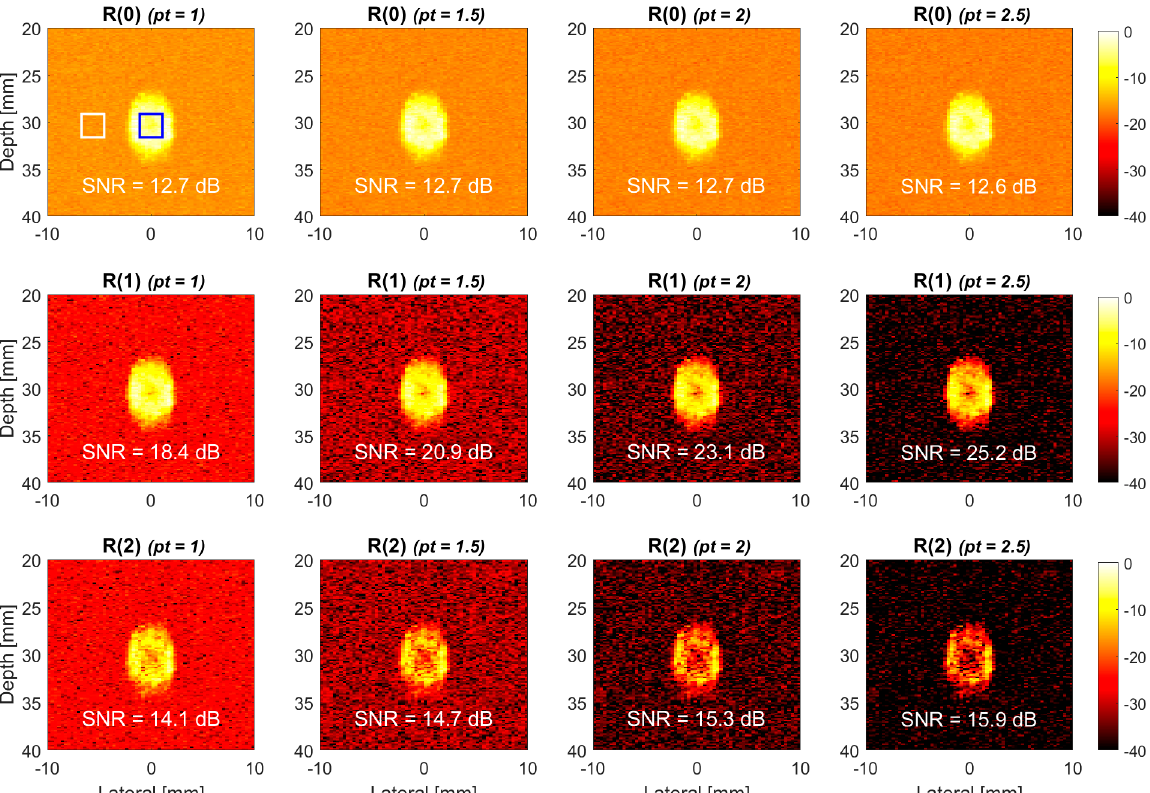
Figure 4. Simulated TMAS power Doppler images of cross-view flow phantom for R(0), R(1) and R(2) images with the pt values of 1.0, 1.5, 2.0 and 2.5, respectively, from left to right. The flow velocity is 310 mm/s, and the inclined angle is 30°.